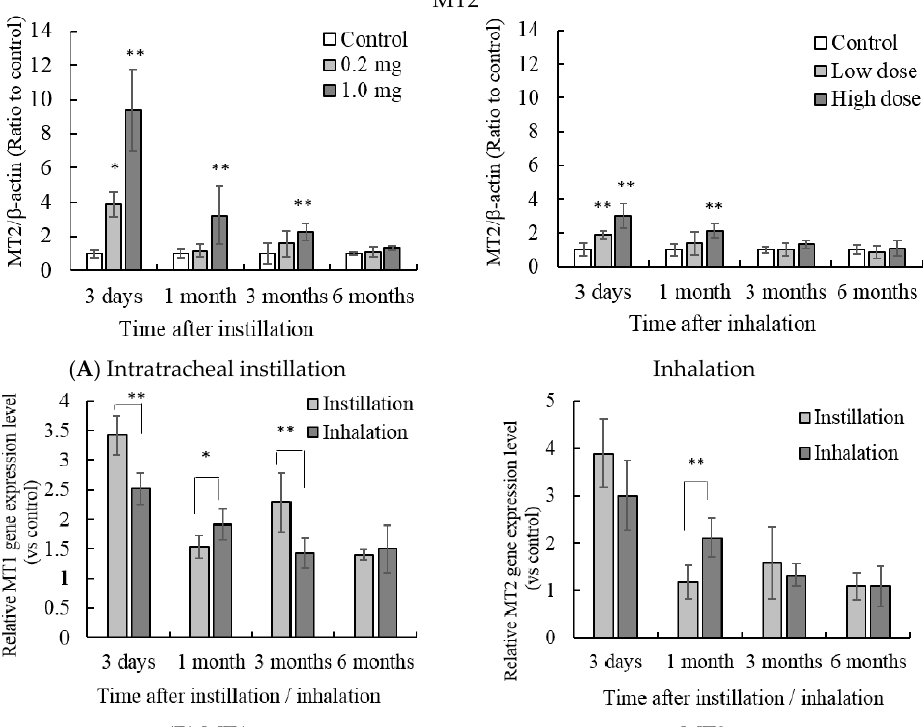
Figure 7. Influence of NiO nanoparticle exposure on the gene expression of metallothionein in the lung. ( A ) mt1 and mt2 gene expression in the lung after intratracheal instillation and inhalation. The gene expression of mt was determined by real-time PCR. Values are mean ± SE ( n = 5). Significant differences versus control group are indicated in the figure (ANOVA, Dunnet). ** p < 0.01, * p < 0.05; ( B ) Comparison of 0.2 mg intratracheal instillation and high dose inhalation. ** p < 0.01, * p < 0.05 (ANOVA, Tukey).